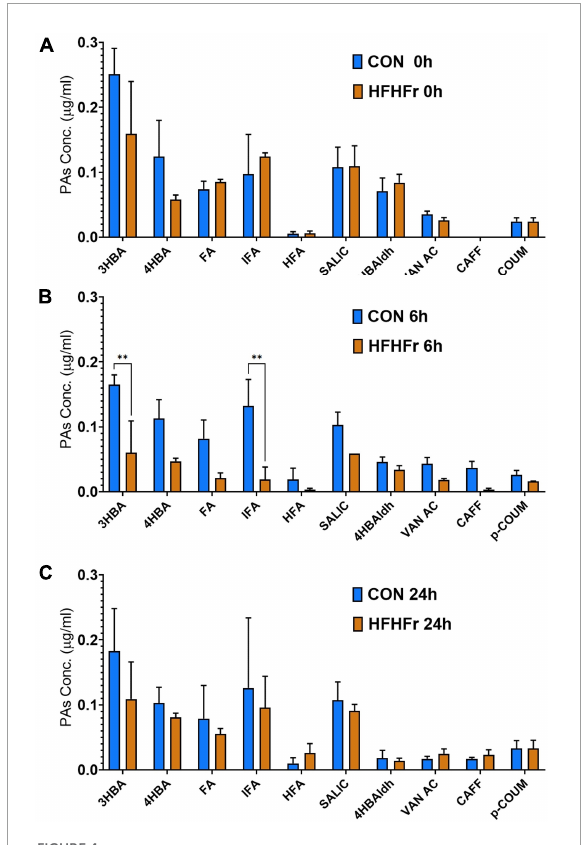
FIGURE4 Levels of the 10 most abundant phenolic acids (PAs, µ g/ml) measured after in vitro batch culture fermentation supplemented with digested wholegrain wheat (WW). The data show the selected PA profile in fermentation supernatants containing fecal slurry from control donors and HFHFr donors at baseline (0 h, A ), 6 h (B) and 24 h (C) . Data are presented as mean ± SEM ( n = 3). ** P < 0.01 (two-way ANOVA and Sidak’s multiple comparison